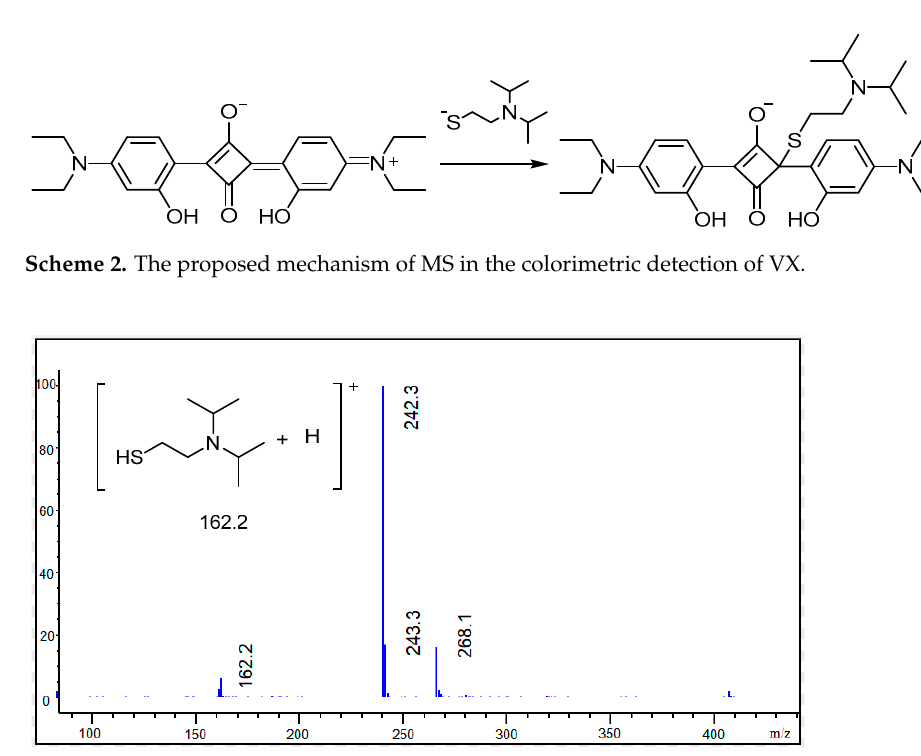
Figure 8. MS of the VX thiol fraction in the mixture of the SP with TBAF and VX.